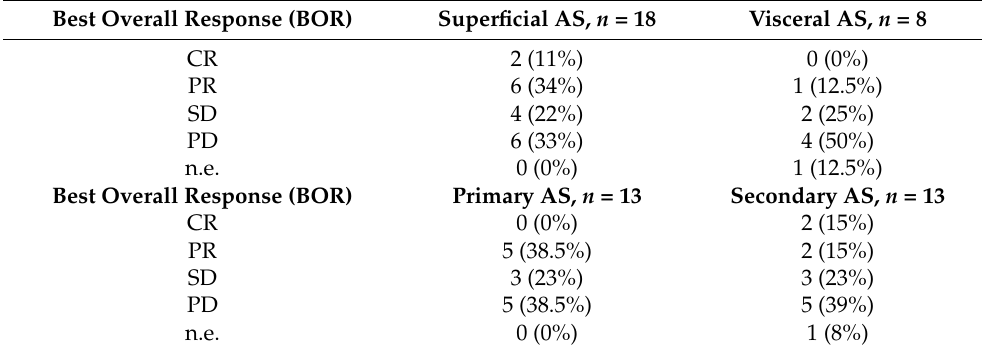
Table 3. Best overall response in absolute and relative (%) frequencies for subgroup analyses. Best Overall Response (BOR) Superficial AS, n = 18 Visceral AS, n =